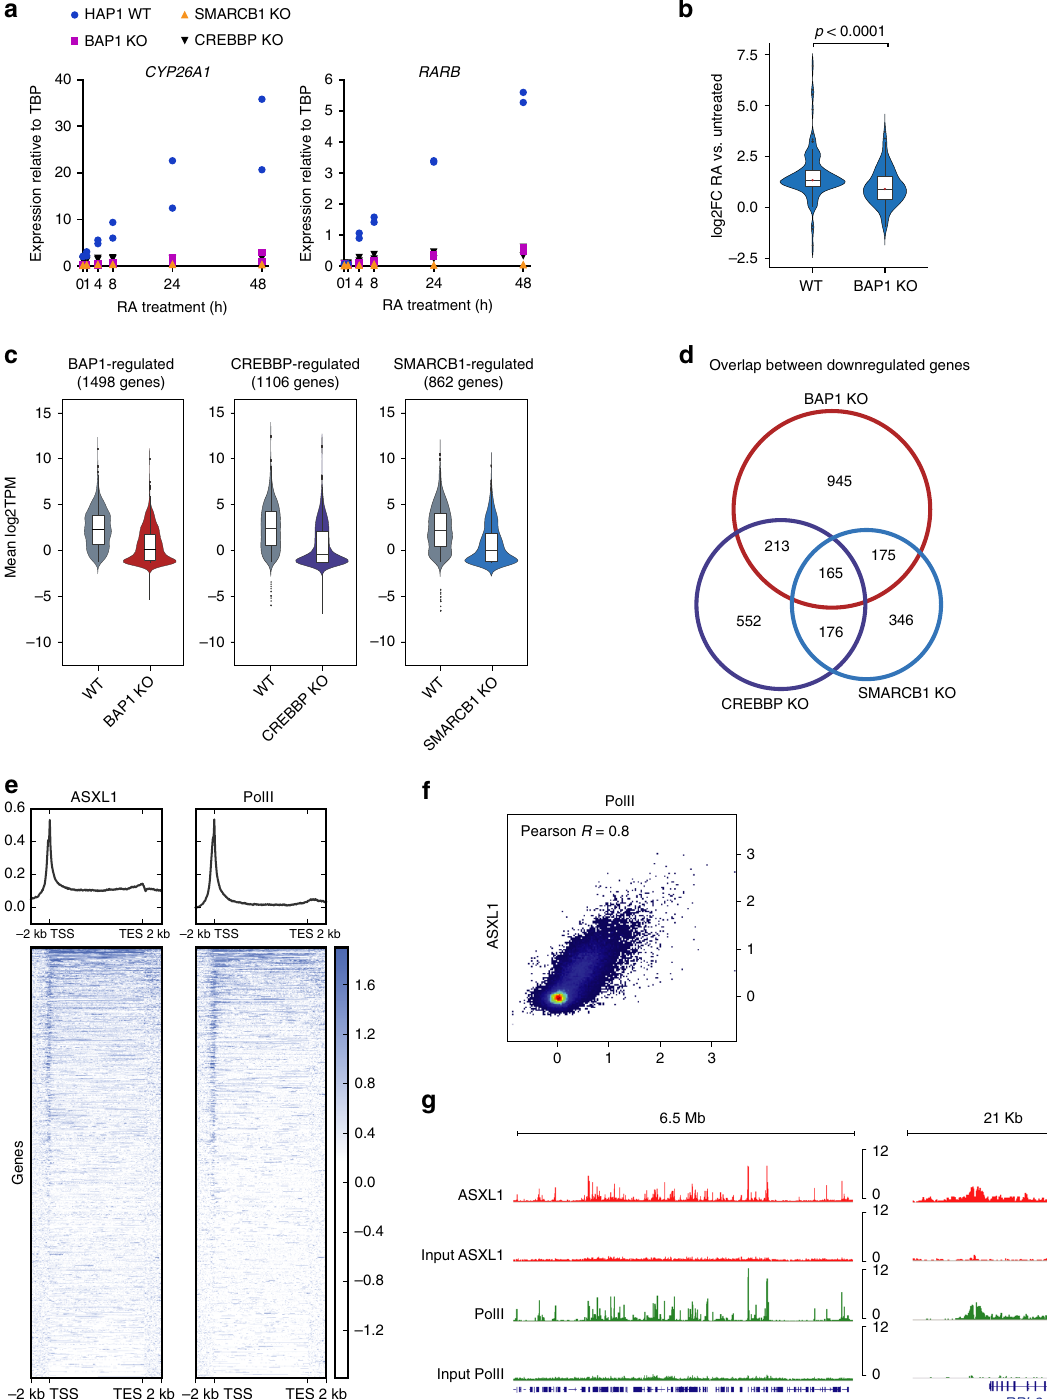
Fig. 5 Comparison of BAP1 and the CREBBP and SMARCB1 co-activator proteins. a RT-qPCR analysis of CYP26A1 and RARB expression following RA treatment at different time-points in wild-type or BAP1 , CREBBP , and SMARCB1 KO cells. n = 2. b Violin plots showing log2 fold-change expression of RA- responsive genes ( n = 114 genes, see text for details) in wild-type and BAP1 KO cells. P -value from the Mann – Whitney test is shown. c Violin plots showing log2TPM expression of BAP1- CREBBP-, and SMARCB1-regulated genes in wild-type (WT) or in the respective KO conditions. d Venn diagram showing overlap between genes that are downregulated in BAP1 , CREBBP , and SMARCB1 KO cells. e Heatmaps showing ASXL1 and RNA PolII density around the TSS and termination end site (TES) (including 2-kb upstream and downstream) scaled to an equivalent 10 kb in human HEK-293 cells. Corresponding average pro fi les are plotted above each heatmap. f Scatterplot showing PolII versus ASXL1 enrichment around the TSS (including 2 kb upstream and downstream) at all annotated genes. Pearson correlation coef fi cient is displayed. g Snapshots of ASXL1 and RNA PolII enrichment at representative regions. The input is displayed below each corresponding ChIP-seq